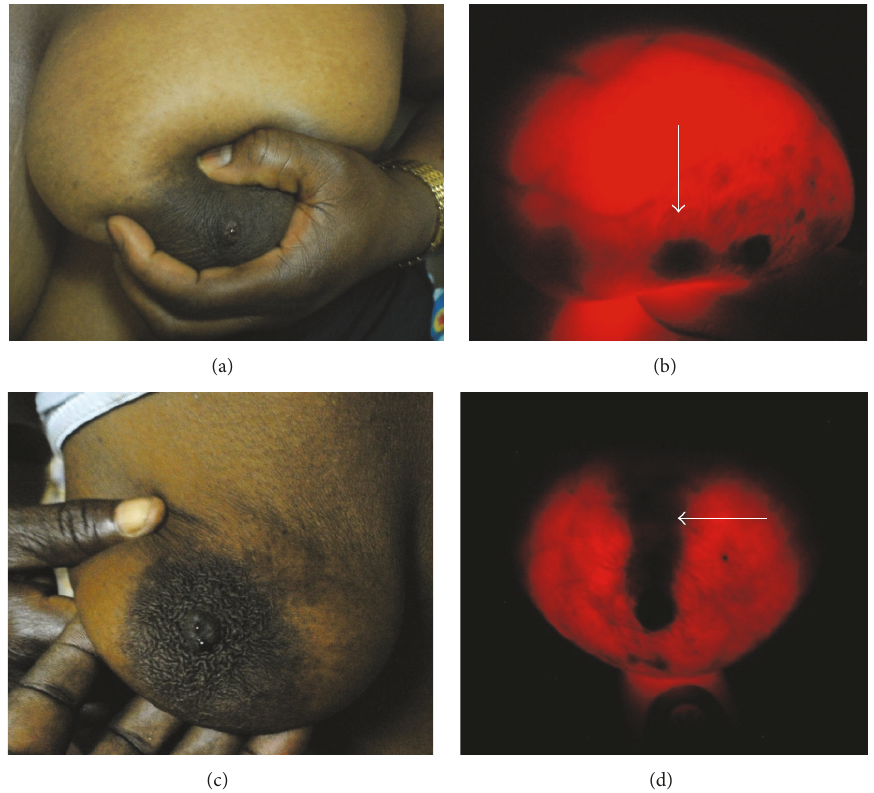
Figure 5: Breast-i locates possible sources of bloody nipple discharge . (a) and (c) are photographed images of bloody nipple discharge when breasts were expressed. Expression was requested upon detection of suspicious lesions from Breast-i examination. (b) and (d) white arrows show possible lesions that may be responsible for the bloody discharge.